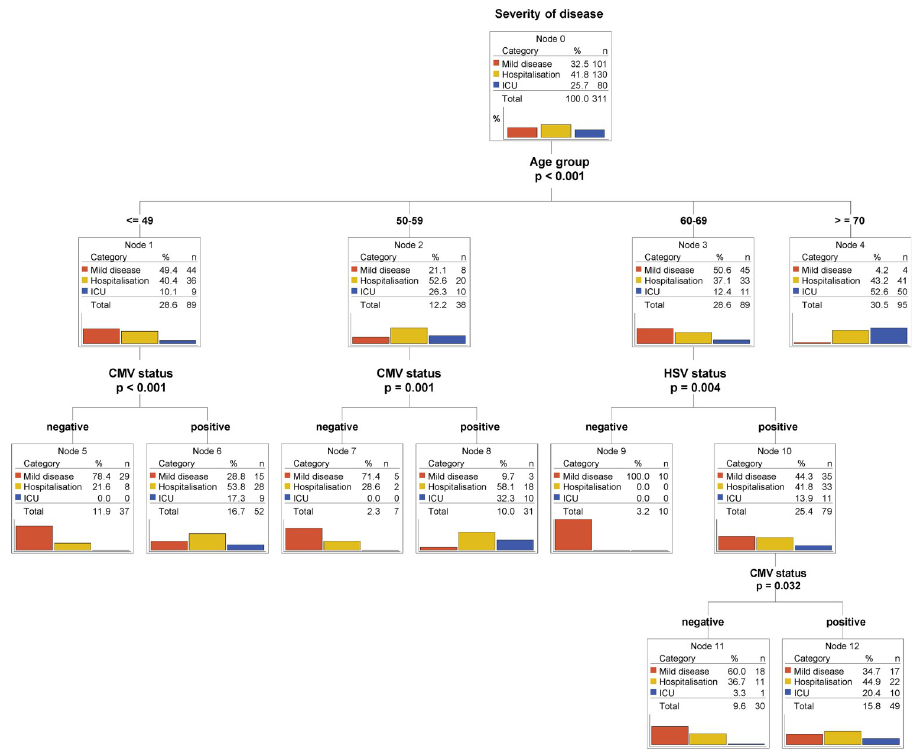
Fig 2. CMV and HSV serostatus predicts outcome in different age groups. Classification tree model (CHAID) using CMV serostatus, HSV serostatus and age as predictors of severity of disease. Bar plots represent percentages. Percentages for categories (mild disease, hospitalization and ICU) are calculated within the node. Percentages for the totals are calculated using the entire dataset.